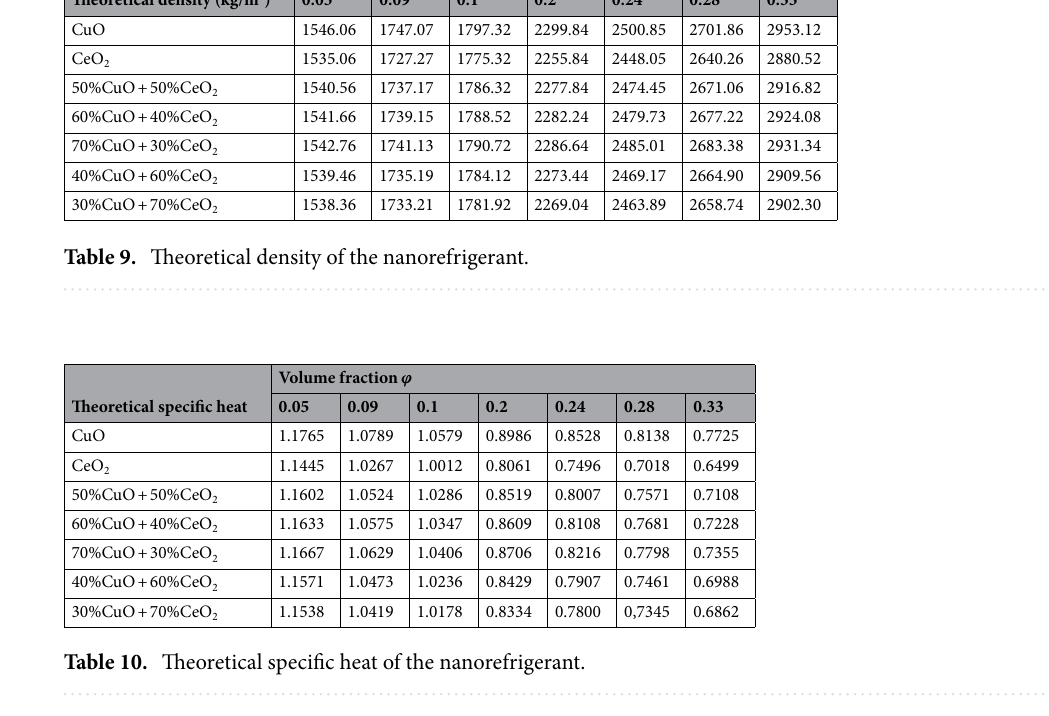
Theoretical density (kg/m 3 )